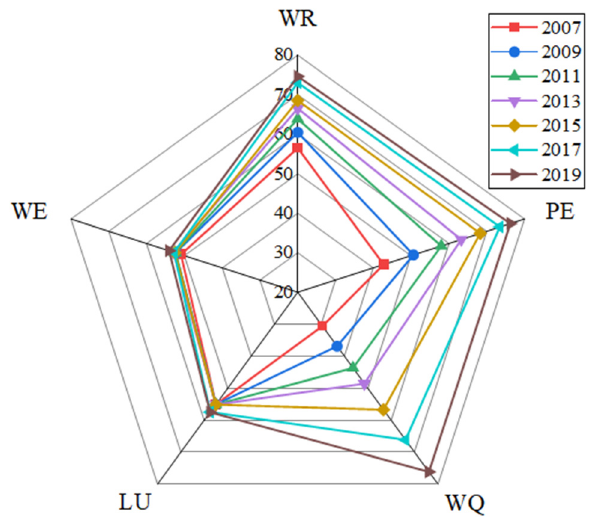
Figure 5. The variation trend of the WECC sub-system scores in Taihu Basin.